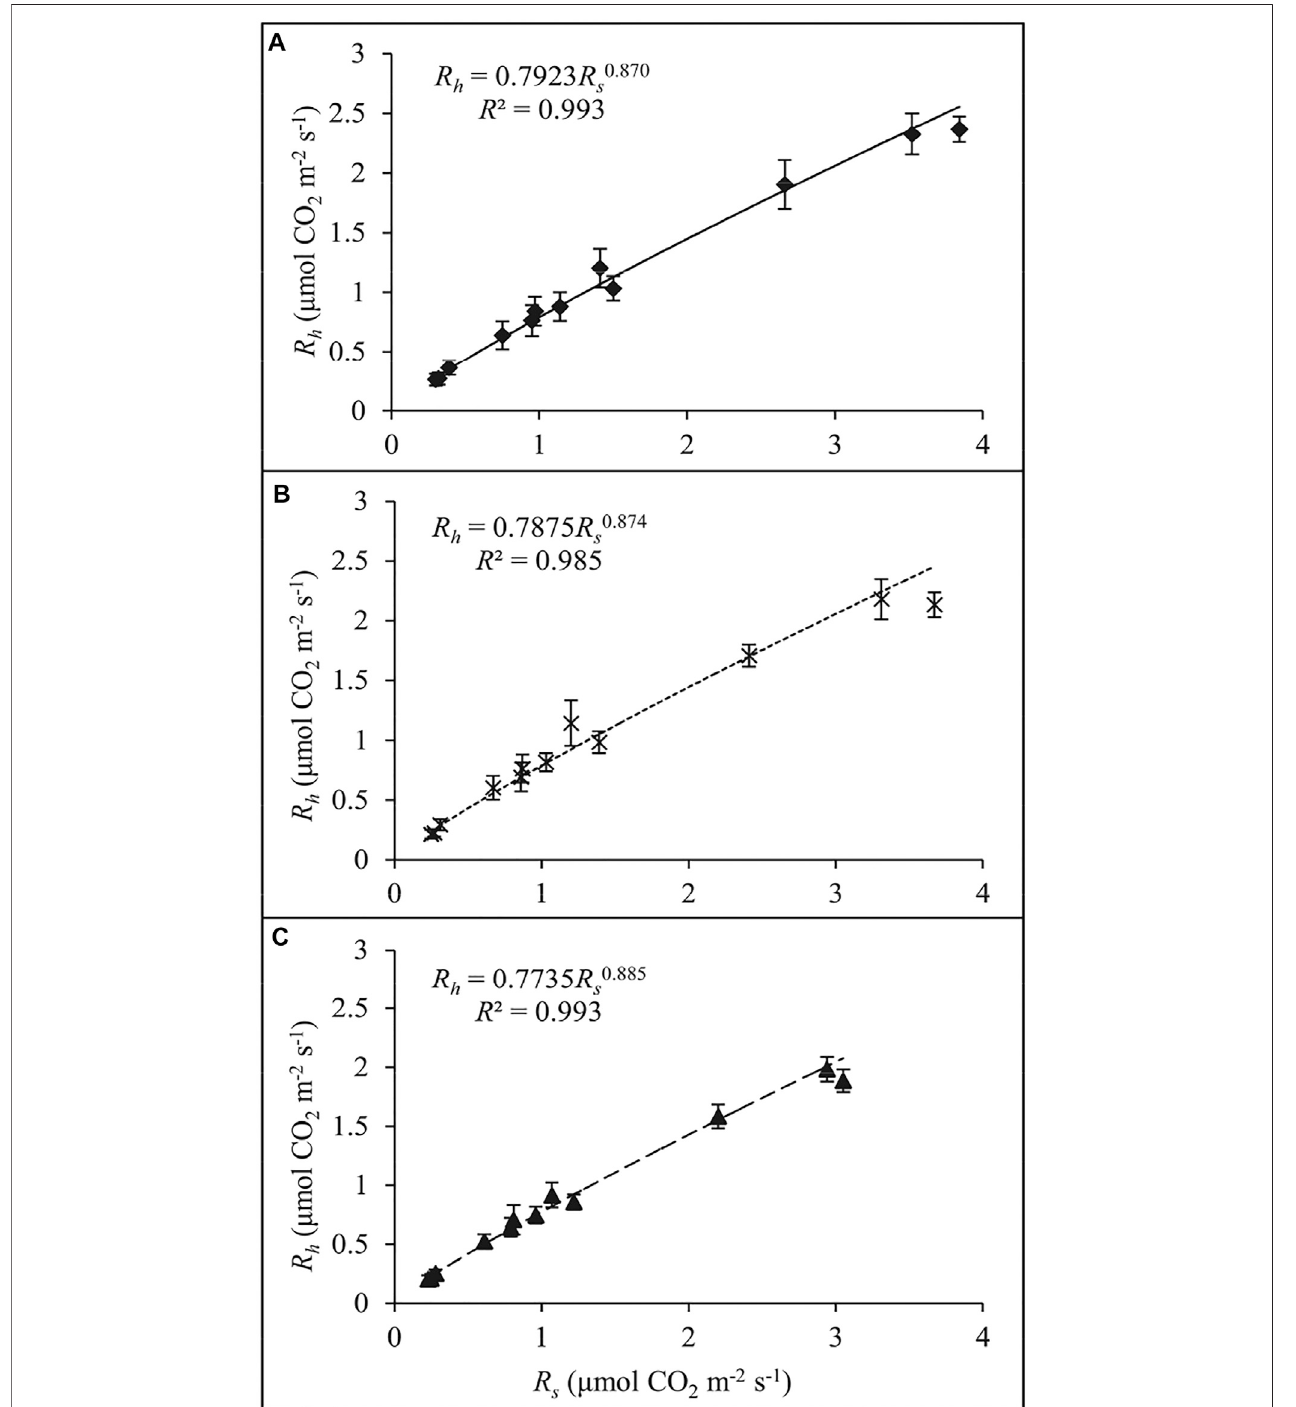
FIGURE 4 | Relationship between soil respiration ( R s ) and its heterotrophic ( R h ) component during the study period. (A) CK: ambient precipitation; (B) PE30: 30% reduced precipitation; (C) PE60: 60% reduced precipitation.